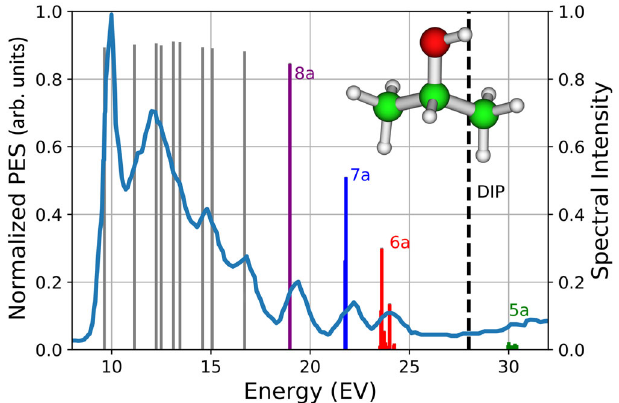
FIG. 1. Photoelectron spectrum of isopropanol, recorded using XUV synchrotron radiation at 90 eV (blue line). Gray vertical lines mark the spectral intensity calculated using ADC(2)x, colored lines are contributions to the spectral intensity of different orbitals 8 a (purple) to 5 a (green). Black dashed line denotes the double-ionization potential of isopropanol at 28 eV, measured at EPFL using spectrally filtered HHG in a photoelectron-photoion coincidence set up. Inset: Ball and stick diagram of the iso- propanol gauche conformer. Our resonant x-ray probe inter- rogates the local electron density at the oxygen site